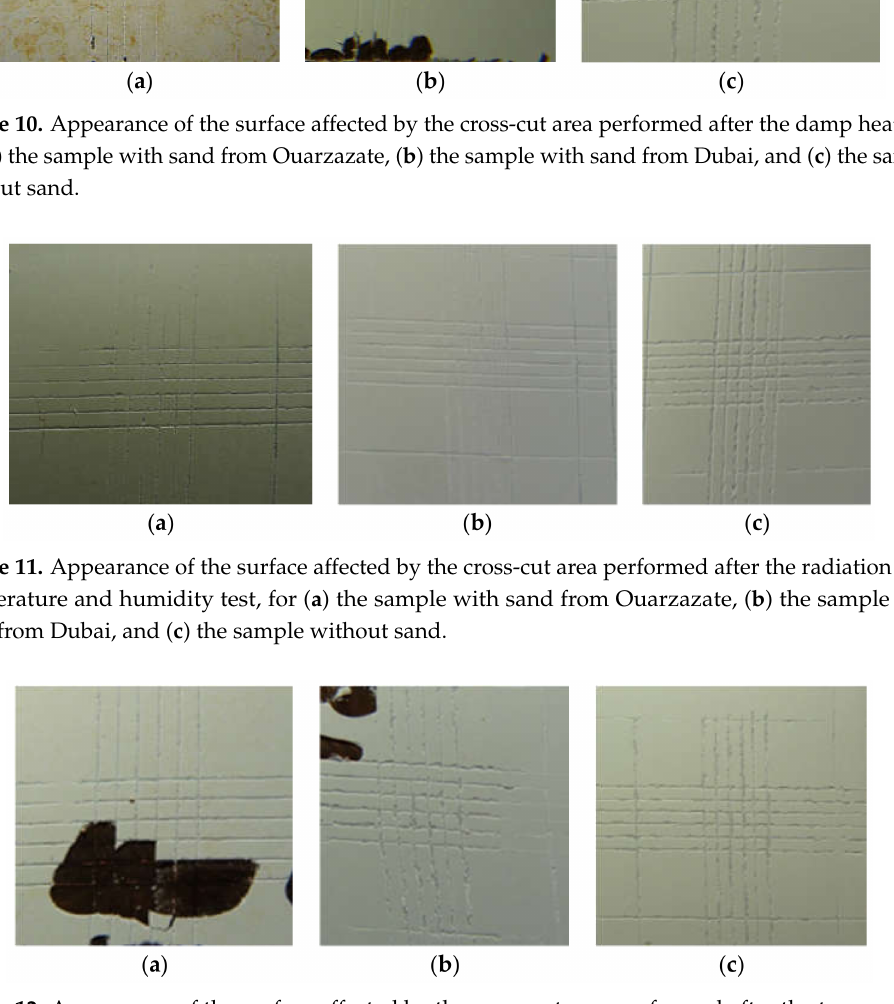
Figure 12. Appearance of the surface affected by the cross-cut area performed after the temperature cycling test, for ( a ) the sample with sand from Ouarzazate, ( b ) the sample with sand from Dubai, and ( c ) the sample without